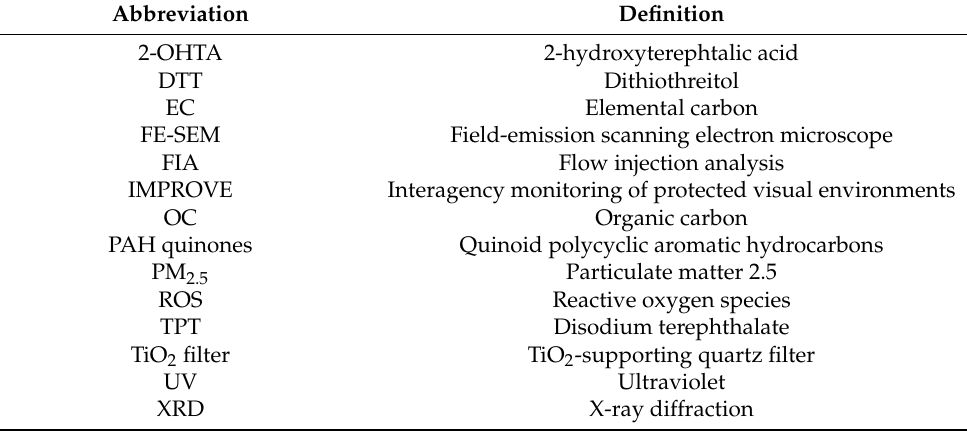
Table 1. List of abbreviations used in the manuscript.